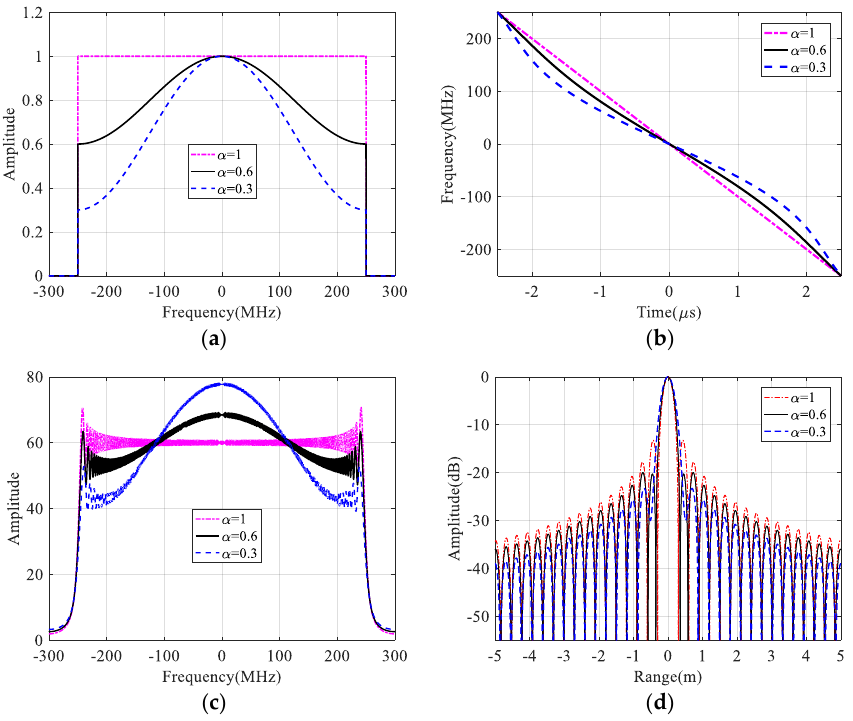
Figure 3. NLFM waveform design results with cosine window functions. ( a ) Raised cosine window functions with different roll – off coefficients. ( b ) Time – frequency relationships of designed waveforms. ( c ) Spectra of designed different waveforms. ( d ) Pulse compression results of designed different signals.